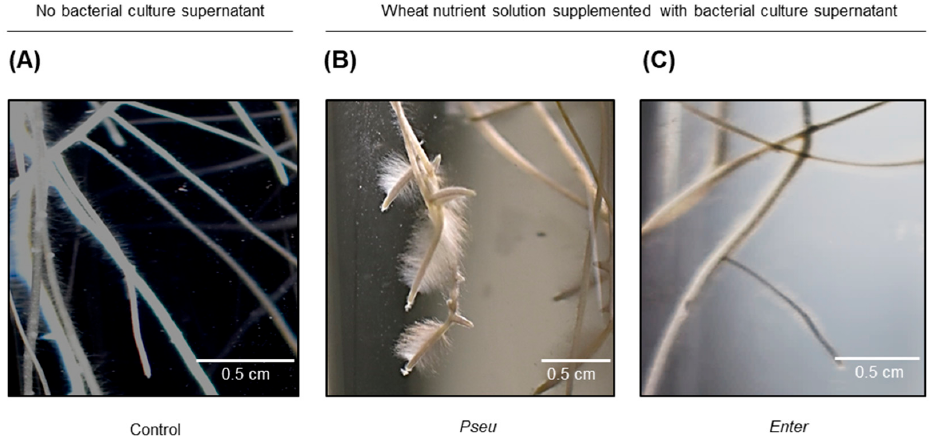
Figure 4. Root hair development induced by BPMP-PU-28 ( Pseudomonas urmiensis ) culture supernatant in lateral roots of durum wheat seedlings cv. Anvergur grown in hydroponics. Durum wheat cv. Anvergur was grown hydroponically under axenic conditions in Hoagland solution, supplemented with bacteria culture supernatant, or mock medium as described in the legend to Figure 3. Representative images of root systems of plants grown for 7 days in the control solution ( A ), or in the solution supplemented with 5% of BPMP-PU-28 (Pseu: Pseudomonas urmiensis ) culture supernatant ( B ) or supplemented with 5% of BPMP-EL-40 (Enter: Enterobacter ludwigii ) culture supernatant ( C ).